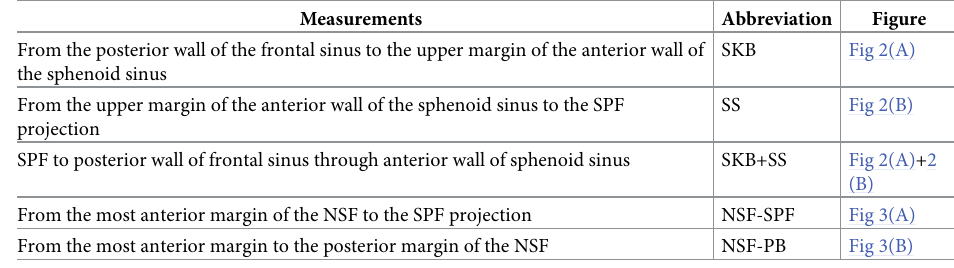
Table 1. Definitions of measurements and their abbreviations, related illustrations. From the posterior wall of the frontal sinus to the upper margin of the anterior wall of the sphenoid sinus